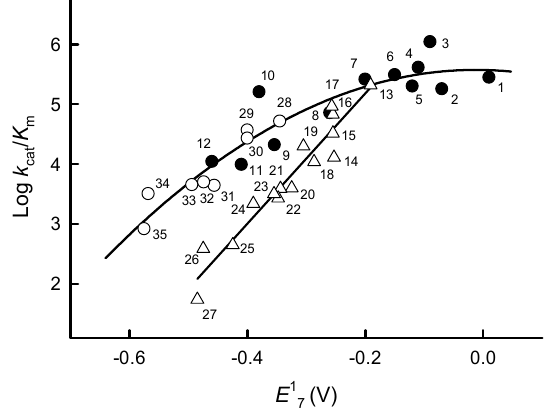
Figure 2. Dependence of the reactivity of quinones, nitroaromatic compounds and aromatic N -oxides on their single-electron reduction midpoint potentials. Relationship between the log k cat / K m of quinones (solid circles), nitroaromatics (blank triangles) and N -oxides (blank circles) and their single-electron reduction midpoint potentials at pH 7.0 ( E 1 7 ). Numbers and reduction potentials of compounds are given in Table 1.